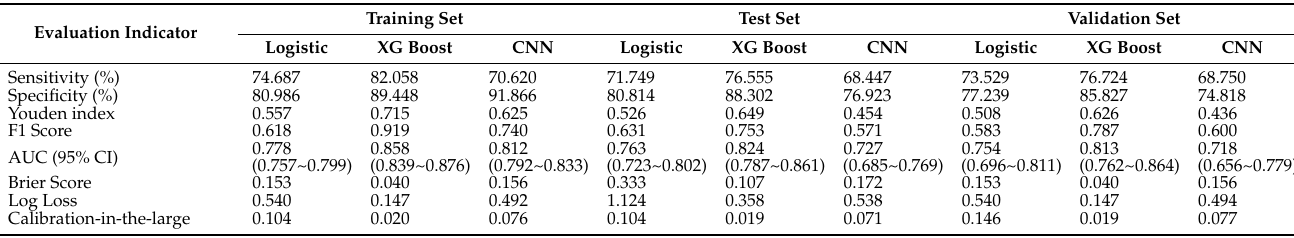
Table 7. Evaluation of three risk